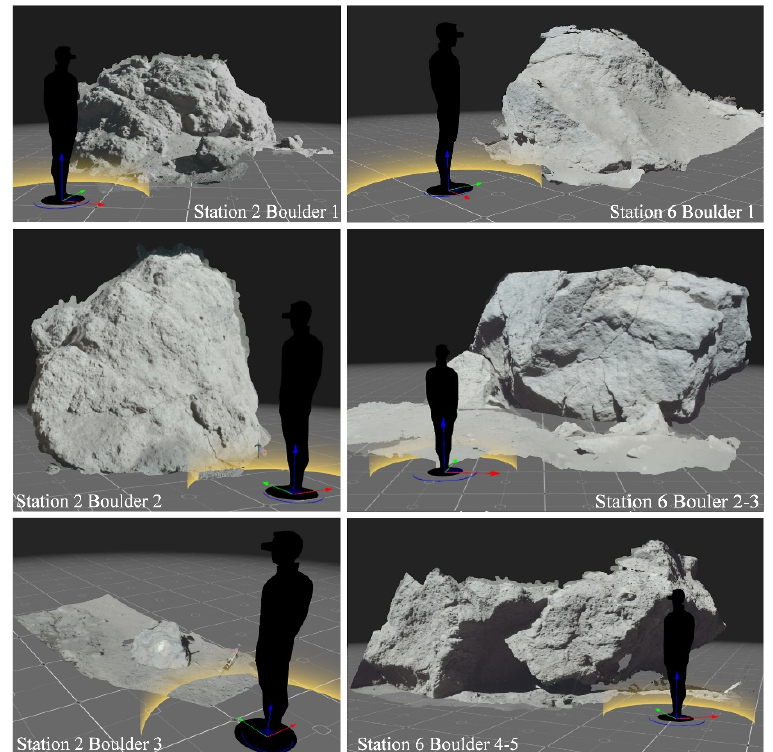
Figure 11. Snapshots of the reconstructed boulder models that can be viewed online on the web-based Sketchfab platform (e.g., https: // sketchfab.com / LPG-3D). Any user equipped with a virtual reality headset can stand in front of these boulders and investigate them in detail at a true scale in virtual reality). The character is 1.80 m tall.